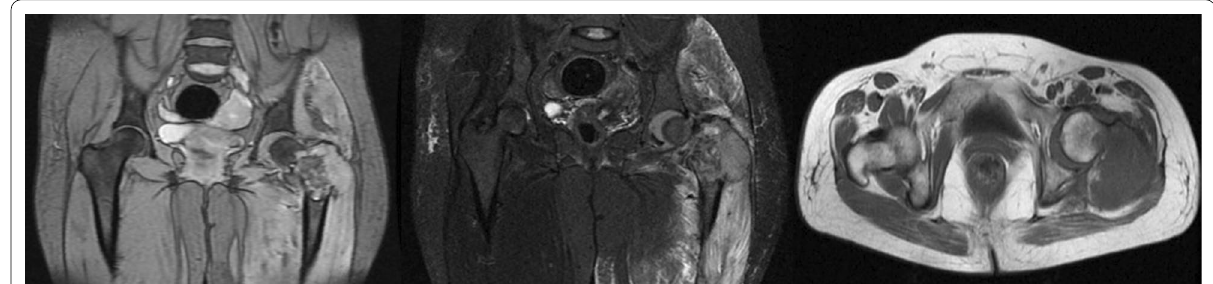
Fig. 3 Coronal GRE/T2* images showing blooming signals due to bone destruction. Coronal STIR images showing hyperintensity in the muscle suggesting myofascial edema. Axial T2WI showing hypointense lesion extending in the neck of